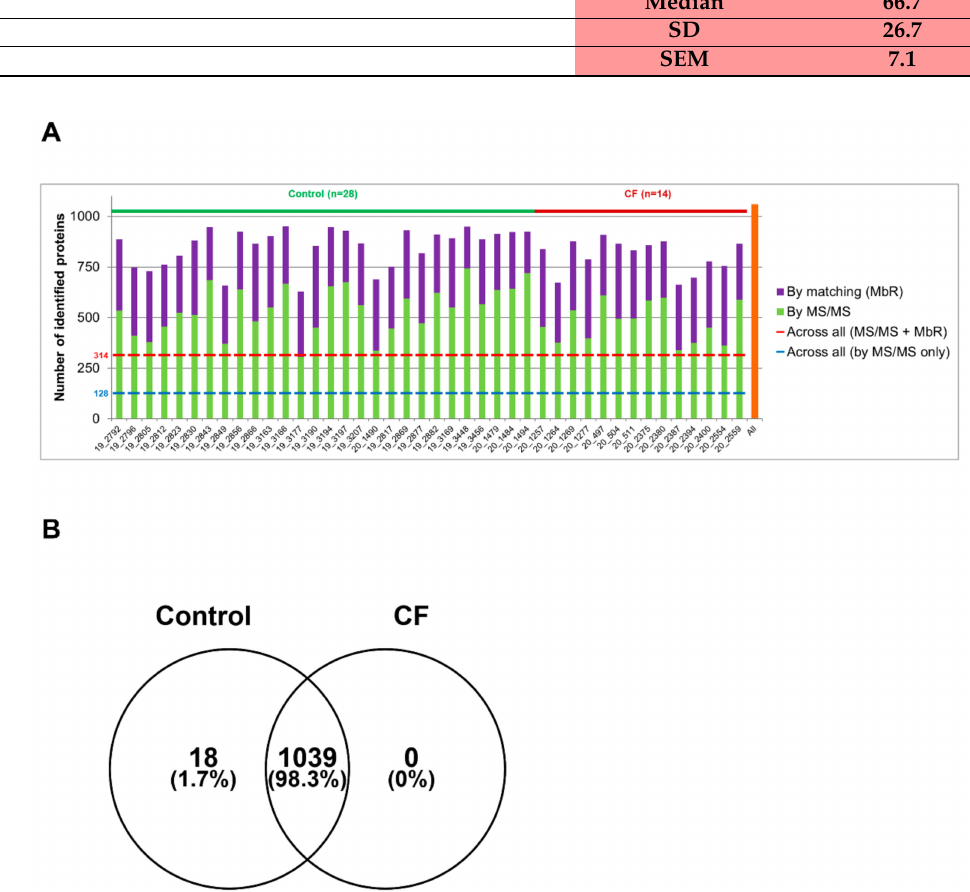
Figure 2. High similarity of control and CF proteome in protein identification ( A ). Number of proteins identified in each sample by MS/MS (in green) and by MbR (in purple), with the total number of identified proteins (in orange). ( B ) Protein identification overlap between control and CF